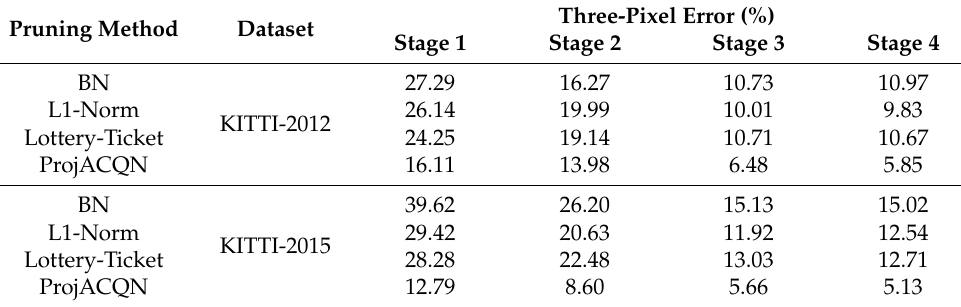
Table 3. Three-pixel error (%) of different pruning methods using AnyNet under 70% energy budget on KITTI-2012 and KITTI-2015